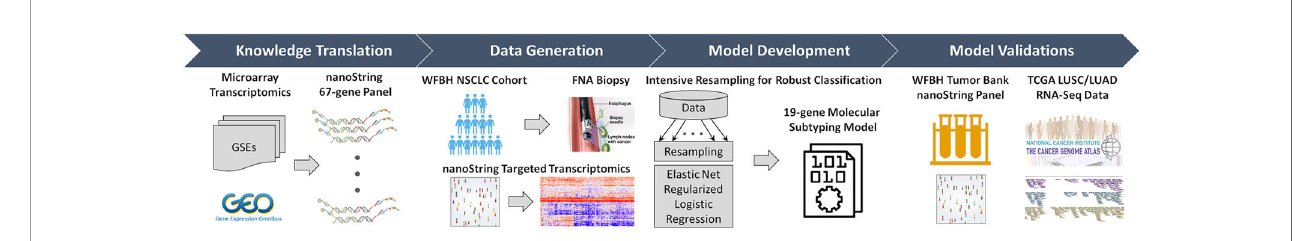
FIGURE 1 | Overall work fl ow of the C2Dx development. The development of the C2Dx NSCLC subtyping device was composed of the following four steps: 1. Knowledge translation. Four microarray-based transcriptomics datasets of NSCLC cases were extracted from Gene Expression Omnibus (GEO) and used to identify 67 subtyping-related genes, including 23 LUAD genes, 40 LUSC genes, and 4 housekeeping genes. A corresponding nanoString gene panel was established. 2. Data generation. Targeted transcriptomics data were generated using the nanoString 67-gene panel for 83 FNA biopsy samples collected from WFBH NSCLC patients, including 47 LUAD, 25 LUSC, and 11 NOS cases. 3. Model development. Intensive resampling strategy was used in elastic-net regularized logistic regression to develop the fi nal 19-gene molecular subtyping model. 4. Model validation. The developed subtyping model was validated using the transcriptomics data of the 19 genes collected from frozen tissue from WFBH ’ s tumor bank using nanoString platform and from the TCGA ’ s RNA-Seq data generated from